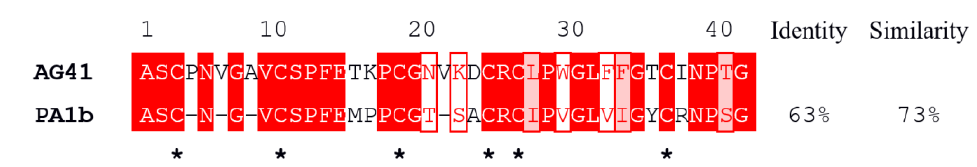
Figure 1. Alignment of PA1b and AG41 sequences. Identical residues are shown on a red back- ground and similar residues are shown in red. The 6 cysteine residues are marked with black aster- isks